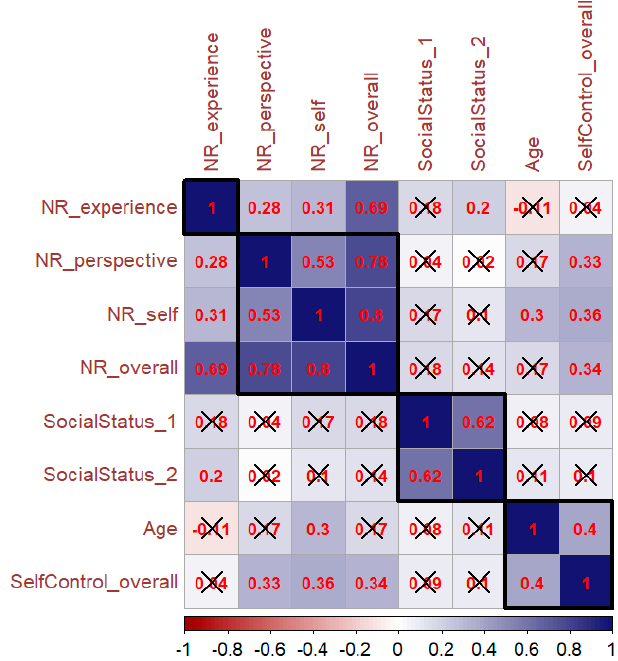
Figure 6. Correlations between NR components and chosen metric variables (men).